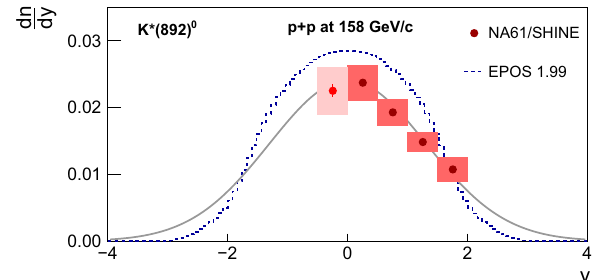
Fig. 14 Comparison of K ∗ ( 892 ) 0 rapidity distribution from NA61/SHINE (points) and the Epos1.99 model (dashed line). The fitted Gaussian function to NA61/SHINE points (solid line) is given by Eq. (17); the first point (with y < 0) was not included in the fit (see the text for details)